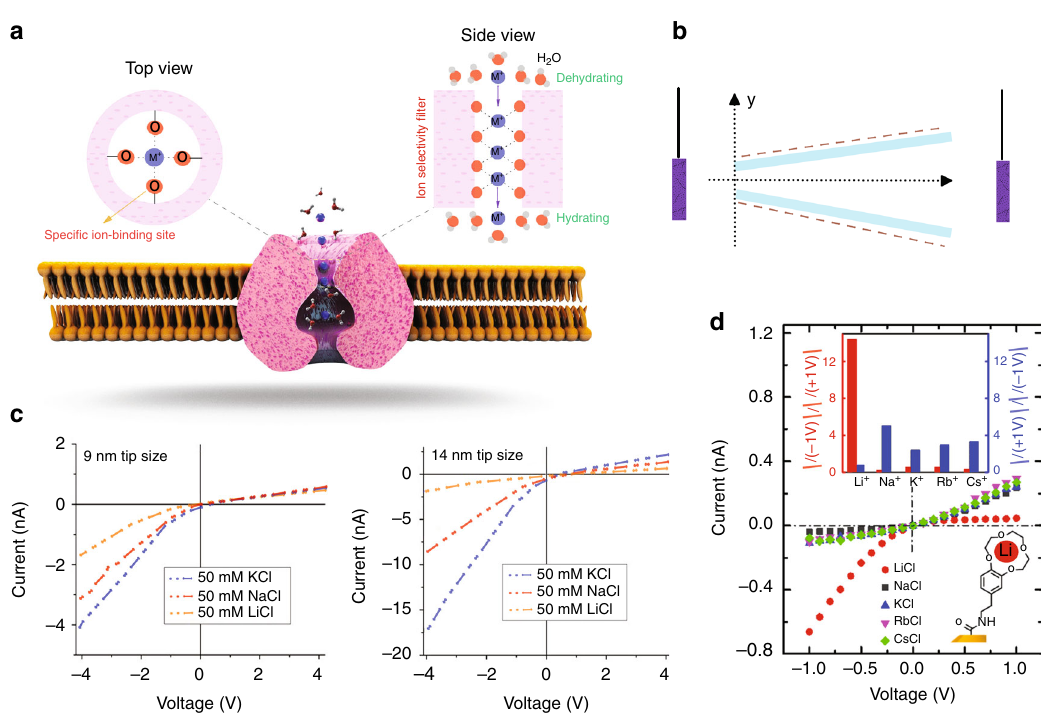
Fig. 7 Effect of nanochannel morphology on Li-ion selectivity and performance. Schematic in a represents a biological ion channel with an angstrom- sized asymmetric ion selectivity fi lter and a nanometer-sized cavity for fast ion transport (Spheres: orange = oxygen, blue = monovalent cations that are surrounded by H 2 O molecules before entering and exiting the nanochannel). In the biological protein nanochannels, ions have a chance to gradually lose their hydration shells as they move into the asymmetric ion fi lter. b A asymmetric nanochannel with ion recti fi cation property (lines: purple = electrodes, light blue = nanochannel walls, dashed red = negative charge). c I – V curves of single conically shaped PET nanopores with a tip diameter of 9 and 14 nm. Li + ions showed the lowest recti fi cation and current, with the effect on the I – V curves becoming less signi fi cant when the tip size diameter increased from 9 to 14 nm 70 . d The characteristics I – V curve of PET conically shaped nanopores modi fi ed with Li + selective receptor moieties (aminoethyl-benzo-12- crown-4 (BC12C4 − NH2), which were exposed to different alkali metal solutions at a concentration of 100 mM and pH of 6.5 (the inset demonstrates the recti fi cation ratio vs. cations at 1 V), Reproduced with permission from 71 Copyright (2019) American Chemical